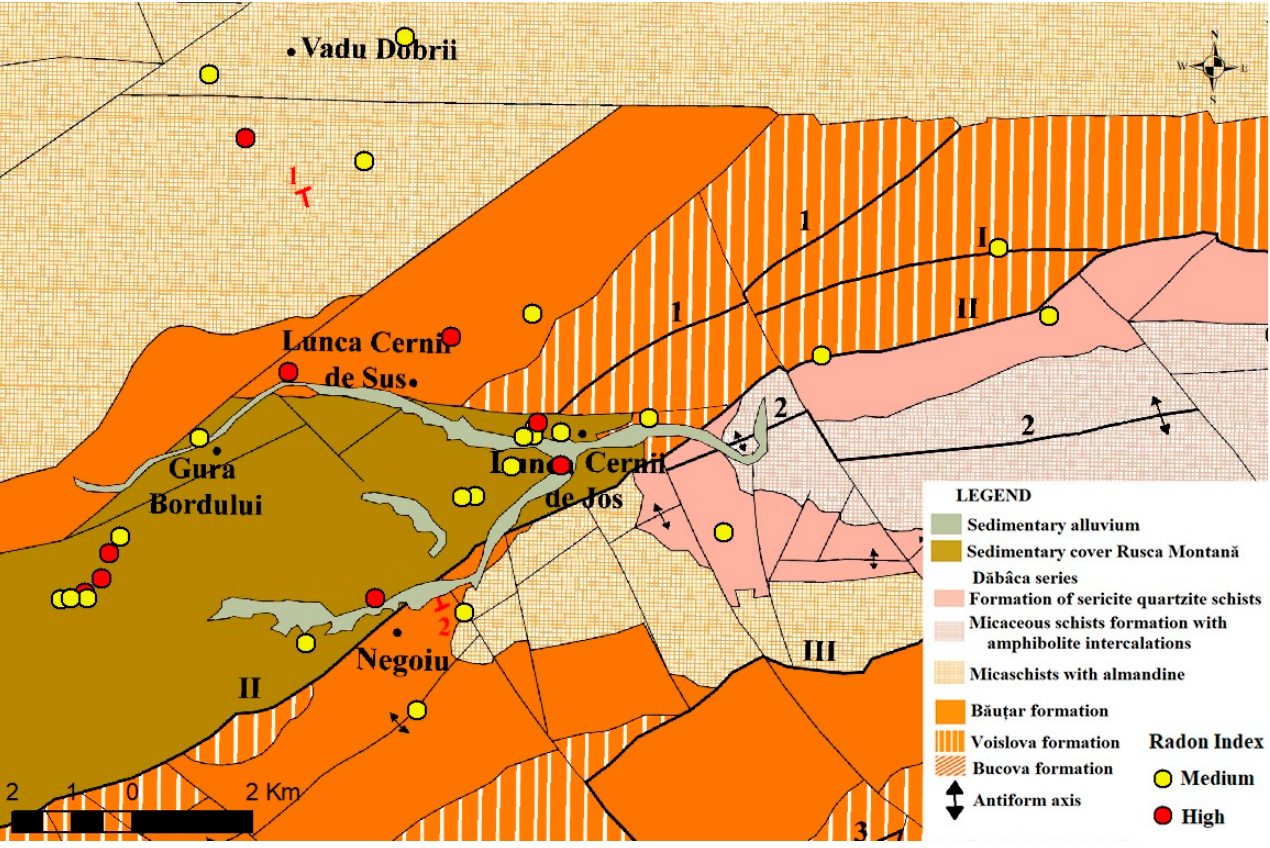
Figure 2. The distribution of measurement points and the radon index in the study area against the geological background, after Maier et al. [32].